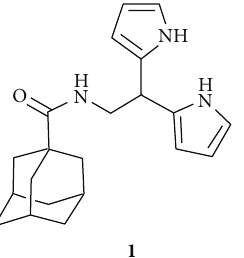
Figure 4: N -(2,2-di(1H-pyrrol-2-yl)ethyl)adamantane-1-carboxa- mide 1